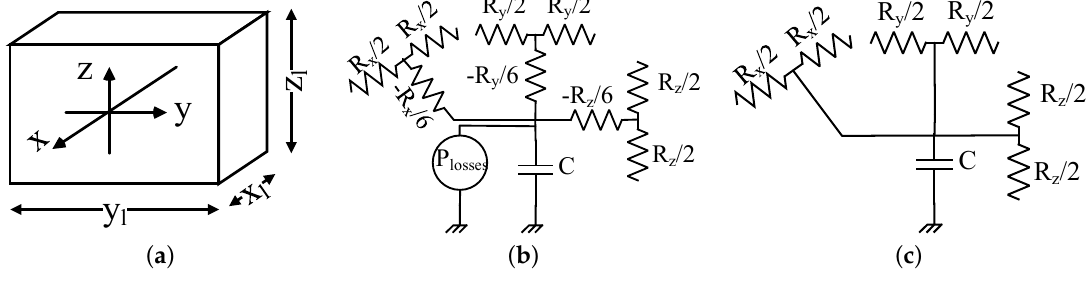
Figure 5. Node network representation. ( a ) Block orientation; ( b ) Resistance model with heat source; ( c ) Resistance model without heat